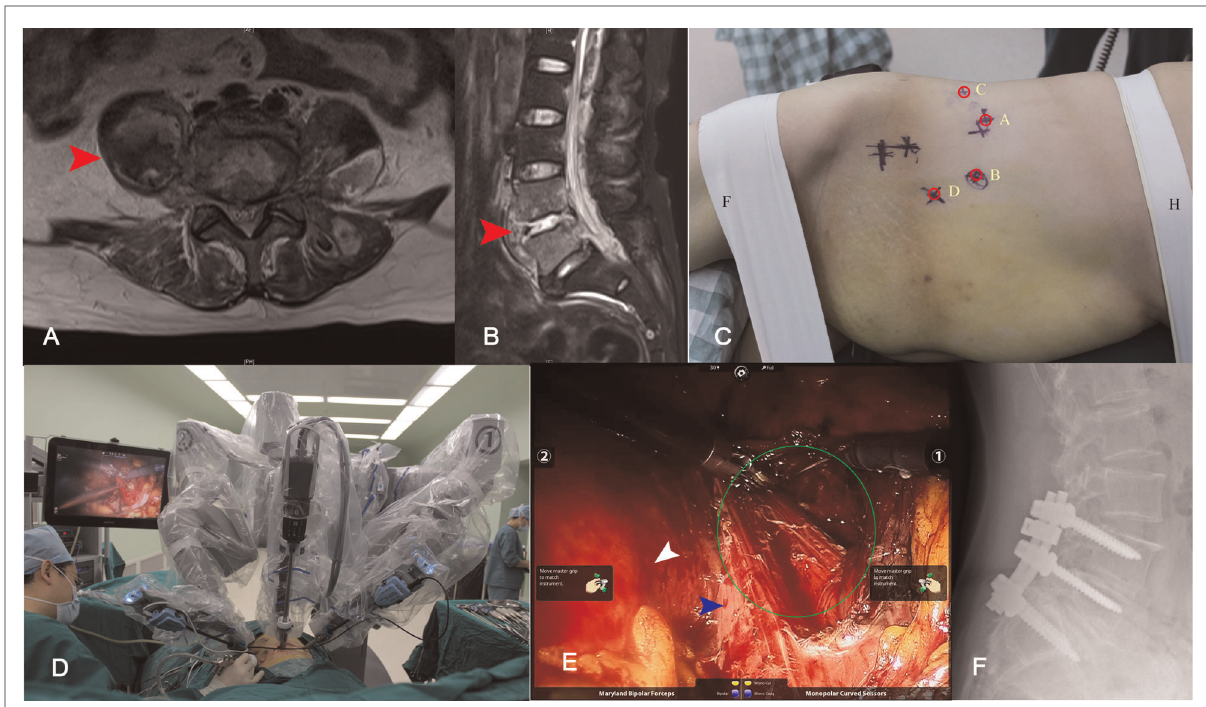
FIGURE 4 Cross section ( A ) and sagittal ( B ) T2-weighted MRI demonstrated destruction at the L4/5 intervertebral space, and a huge abscess formation at the paravertebral (red arrow). The location of the working channel was planned before the operation ( C ), the abscess and L4/5; the intervertebral disc tissue was removed during operation ( D, E ). Endoscopic view of the procedure, peritoneum (white arrow), psoas muscle (blue arrow), and abscess (green circle) ( E ). Twenty-eight months after operation, x-ray showed a good internal fi xation position and fusion of L4/5 intervertebral ( F